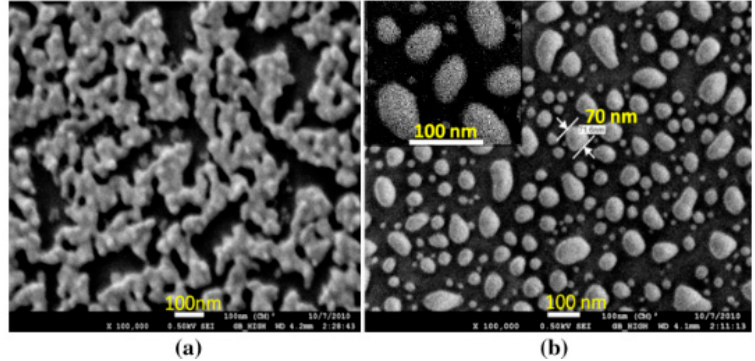
Figure 7. SEM images of three-dimensional (3-D) gold nanostructures ( a ) as deposited and ( b ) after annealing at 550 °C for 1 h (reproduced from [43], open access paper).